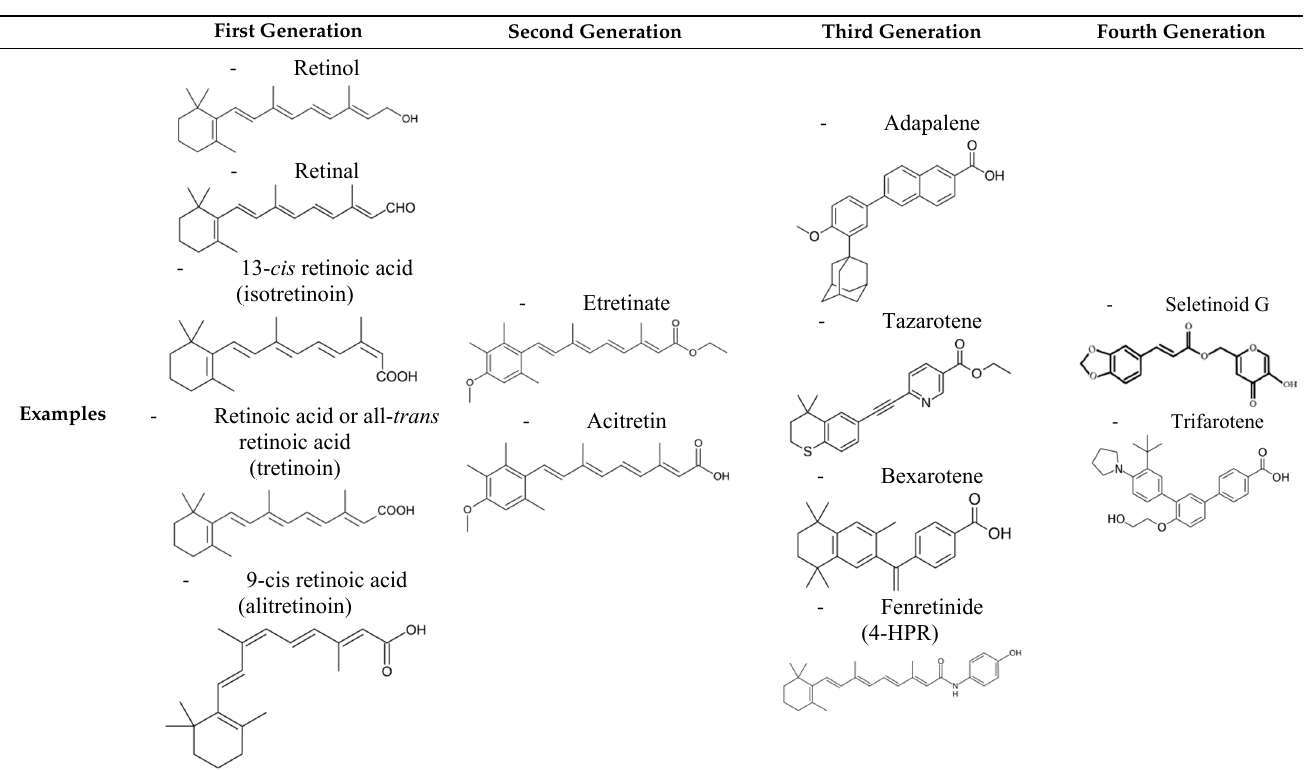
Table 1. Retinoids classification: retinoids are classified into four generations based on their chemical modification [20– 22] .